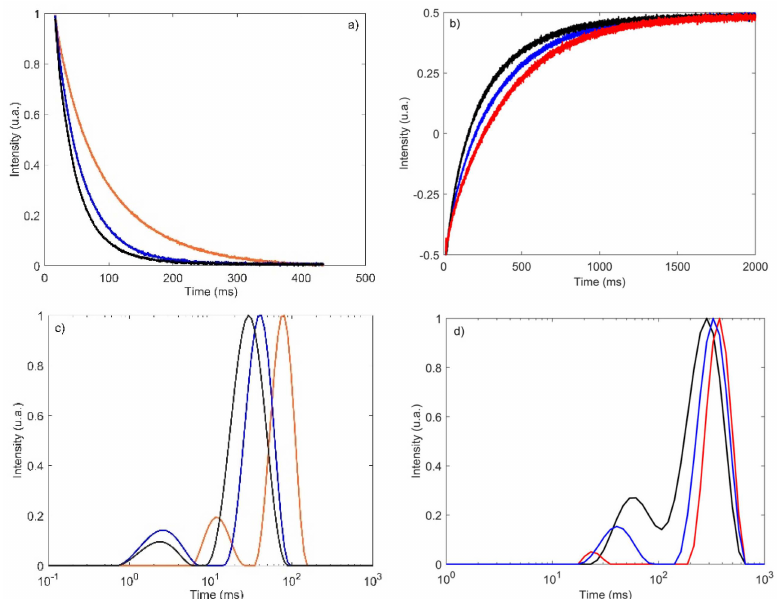
Figure 1. ( a ) CPMG and ( b ) CWFP-T 1 relaxation curves of three RC samples with different chemical compositions and the respective relaxation spectra ( c , d ) obtained with the ILT algorithm [35]. RC samples with the lowest, medium, and the highest moisture contents are the black, blue, and red lines,